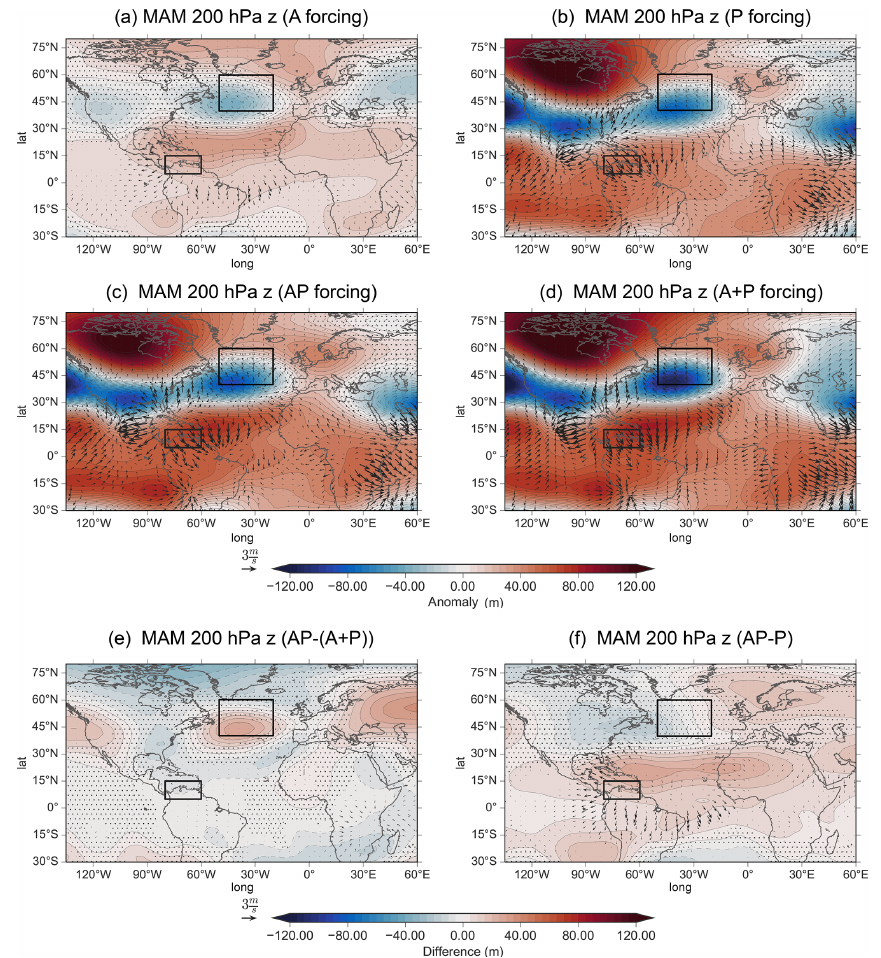
Figure 9. Same as Fig. 6 but for MAM 200hPa geopotential height (shading) and 200hPa irrotational winds (vectors). The black box in North Atlantic represents the East Atlantic